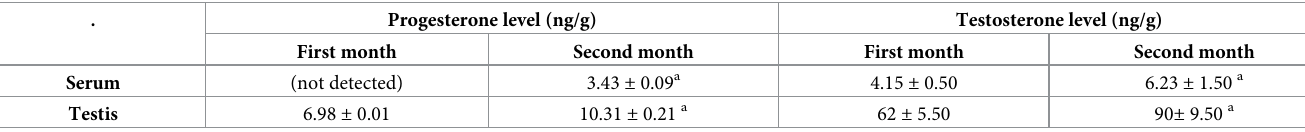
The data presented as mean ± S.E. a Significant difference as compared to the data of a month ( P �